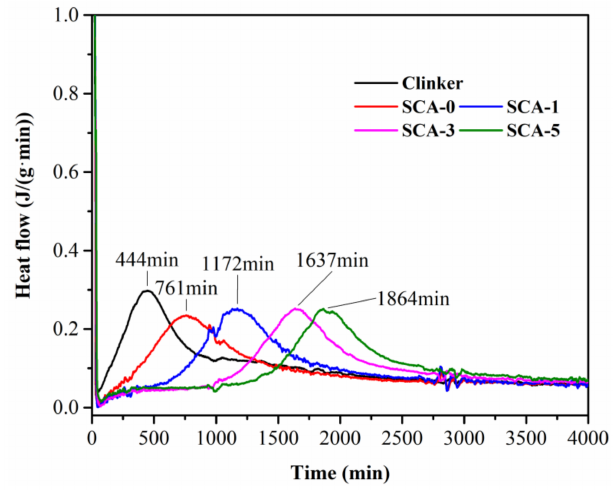
Figure 5. Heat evolution of clinker and microsphere paste with w / c ratio of 0.35 measured by isothermal calorimetry.